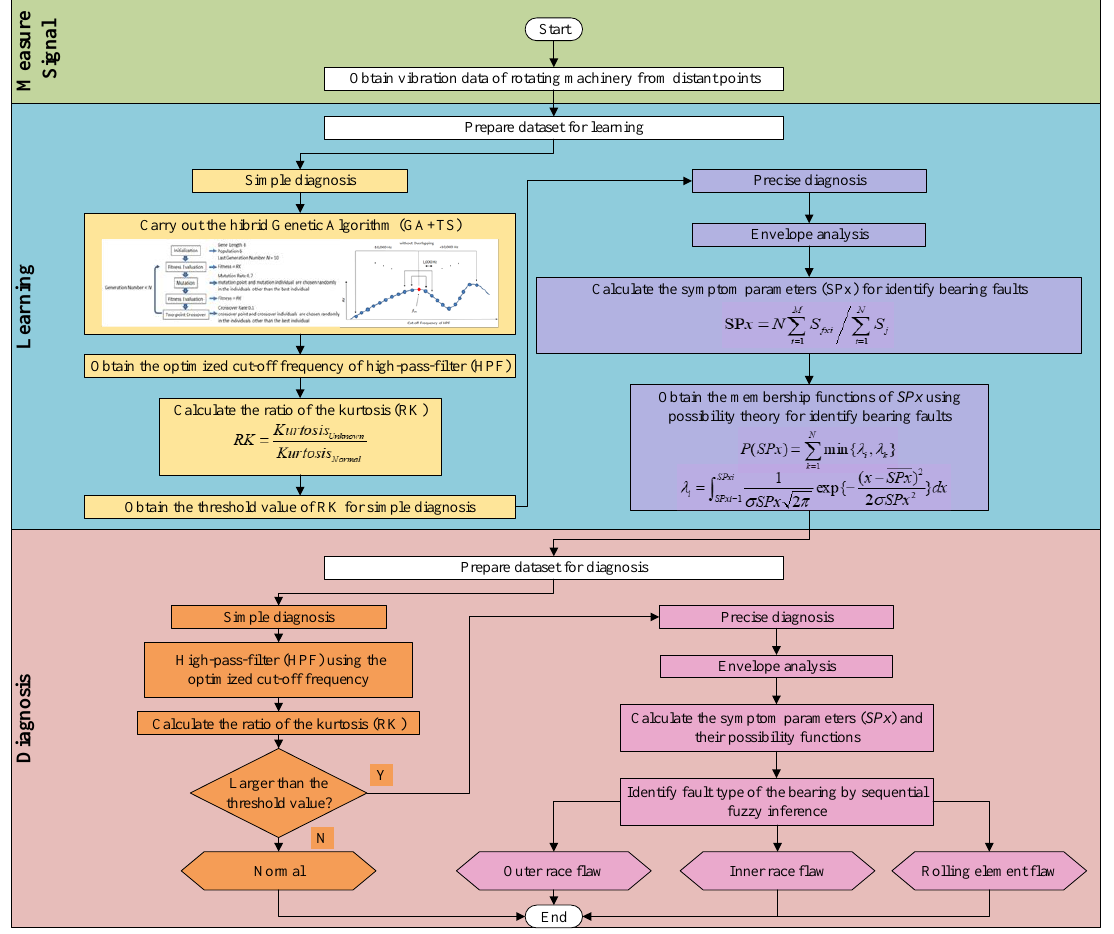
Figure 1. Flowchart of the diagnosis process proposed in this